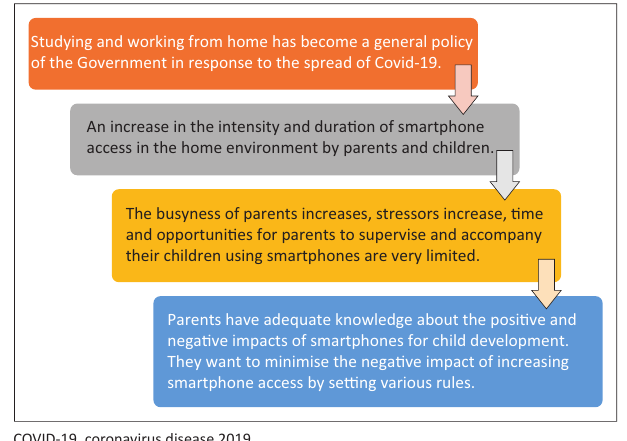
COVID-19, coronavirus disease 2019. FIGURE 1: Theoretical framework.